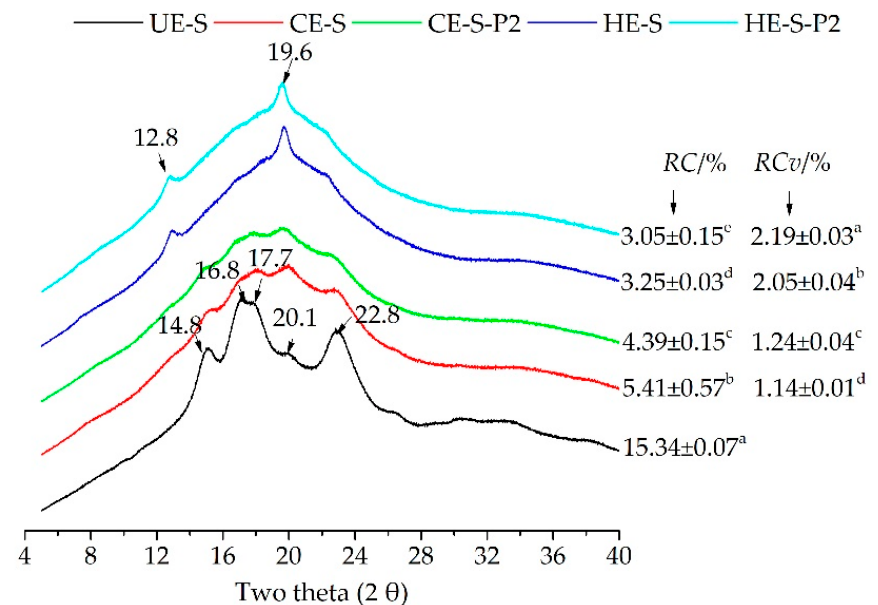
Figure 1. XRD pattern of native buckwheat starch, cold and hot extruded noodles with starch, and phenolic extracts. UE-S, unextruded (native) buckwheat starch; CE-S, cold extruded noodles with starch only; CE-S-P2, cold extruded noodles with starch and phenolics (2.0%); HE-S, hold extruded noodles with starch; HE-S-P2, hold extruded noodles with starch and phenolics (2.0%); RC , relative crystallinity; RC v , relative crystallinity of V-type crystallites. Different letters in a column represent values that are significantly different ( p < 0.05).